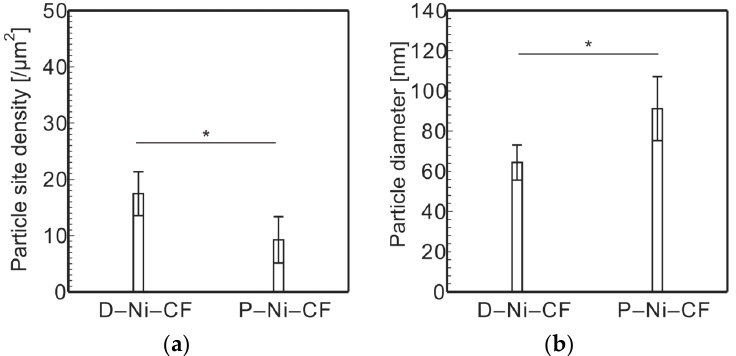
Figure 6. Measurement results of ( a ) particle site density (n = 27, mean ± S.D., * p < 0.05, Welch’s t test) and ( b ) particle diameter (n = 45, mean ± S.D., * p < 0.05, Welch’s t test) ( I = 200 mA, J = 3.79 A/m 2 , t ON = 10 ms, t OFF = 100 ms, t = 5 s).